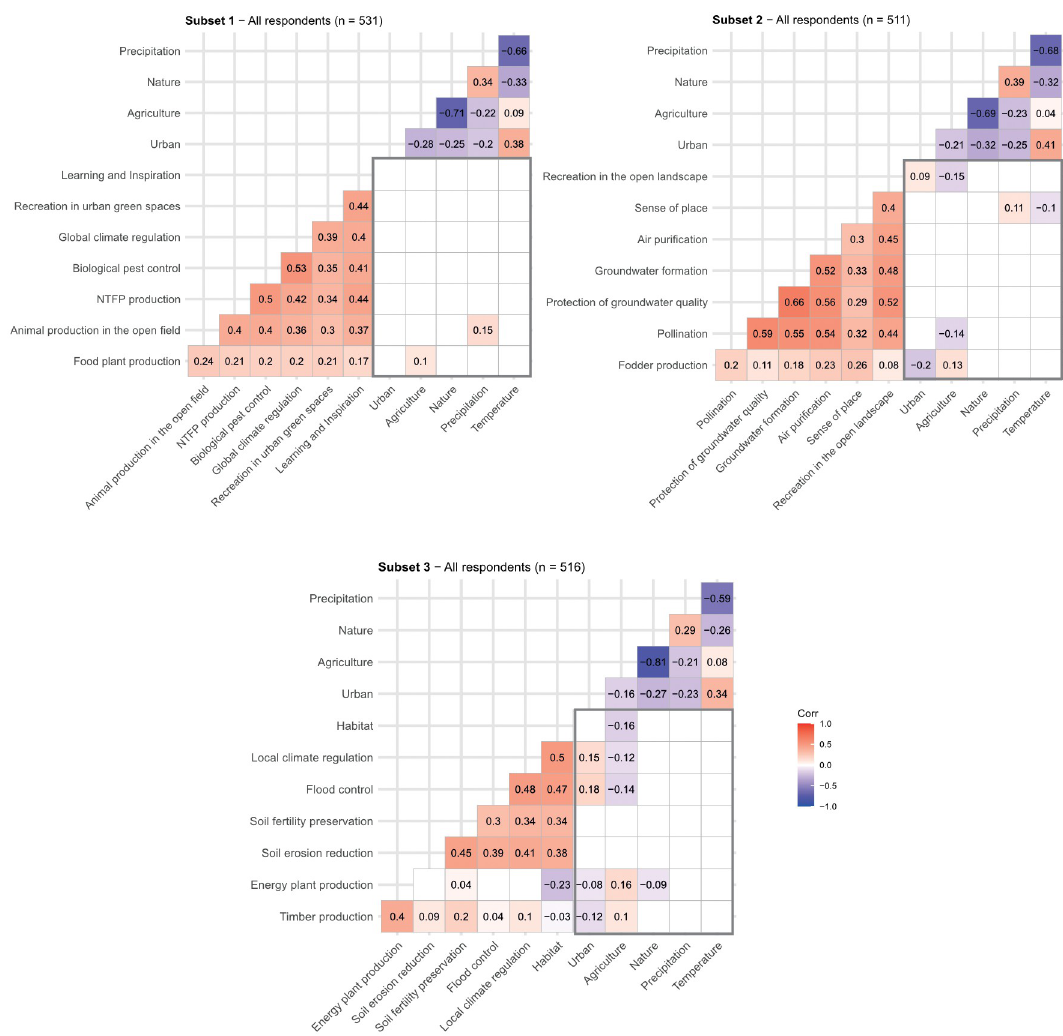
Fig 5. Correlation plots between ecosystem services and gradient variables. The grey rectangle frames the area of potential correlation between ecosystem services perceptions and gradient variables. Spearman correlation is calculated. Only significant correlations at p < 0.05 are shown, insignificant relationships are left